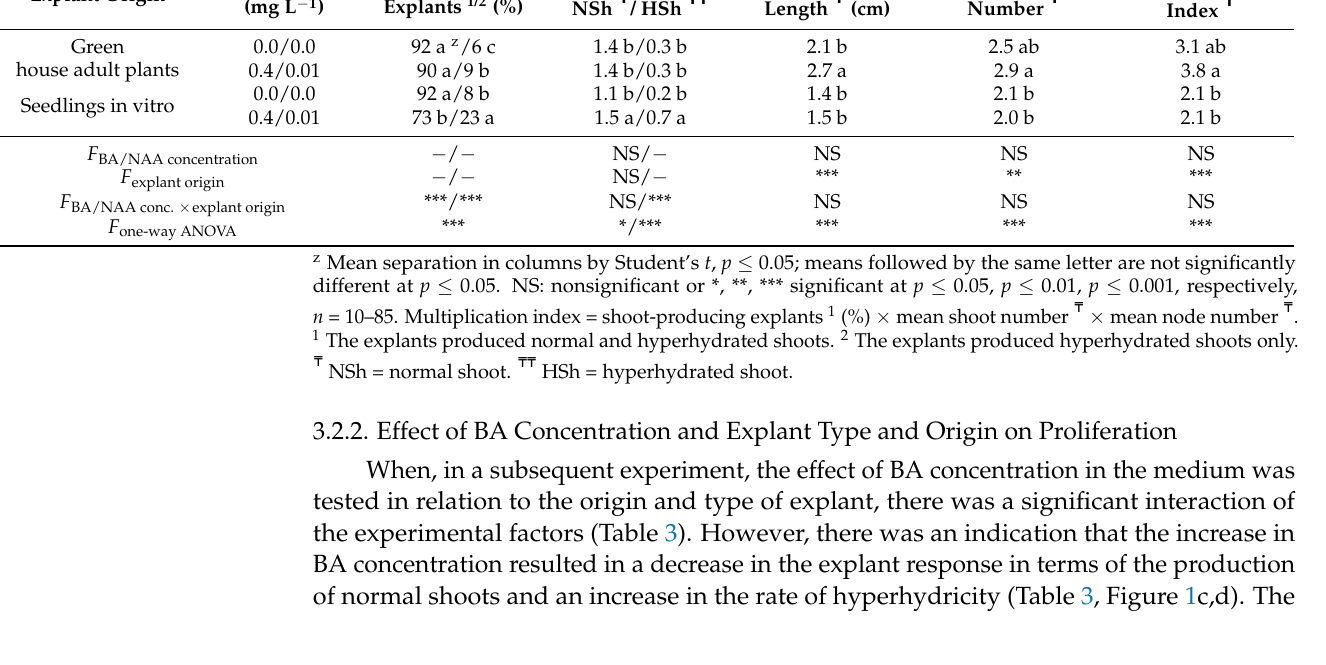
Table 2. Effect of explant origin and plant growth regulators in the medium on axillary shoot proliferation of S. tomentosa shoot tip and single node explants (mixed) at subcultures (means of six subcultures).